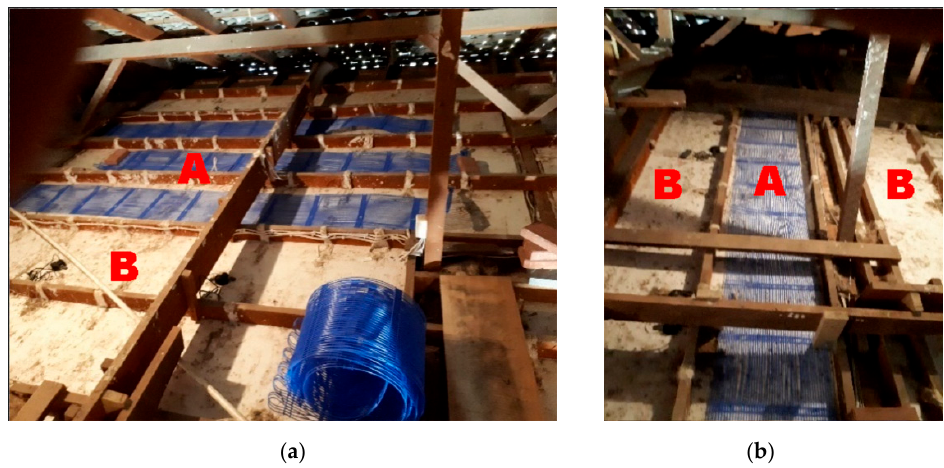
Figure 8. Capillary tube installation on a ceiling: ( a ) Capillary mats on existing plasterboard ceiling; ( b ) Batt insulation cover the top of Capillary mats. Source: KPW solutions.